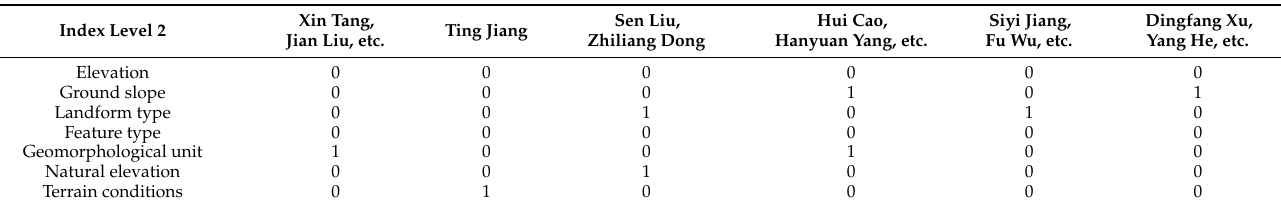
Table A7. Second level index binarization matrix.